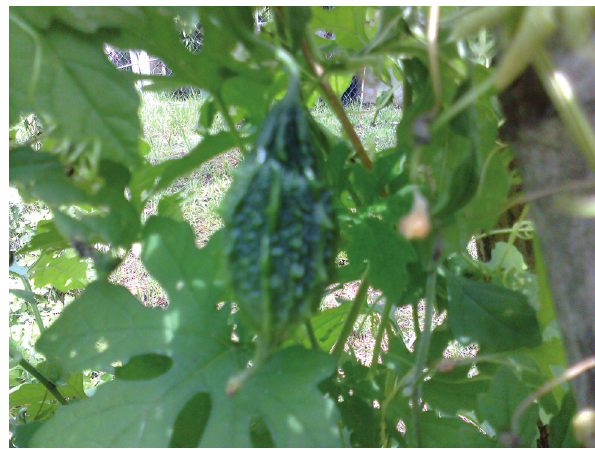
Figure 1: Photograph of M. charantia fruit used in this